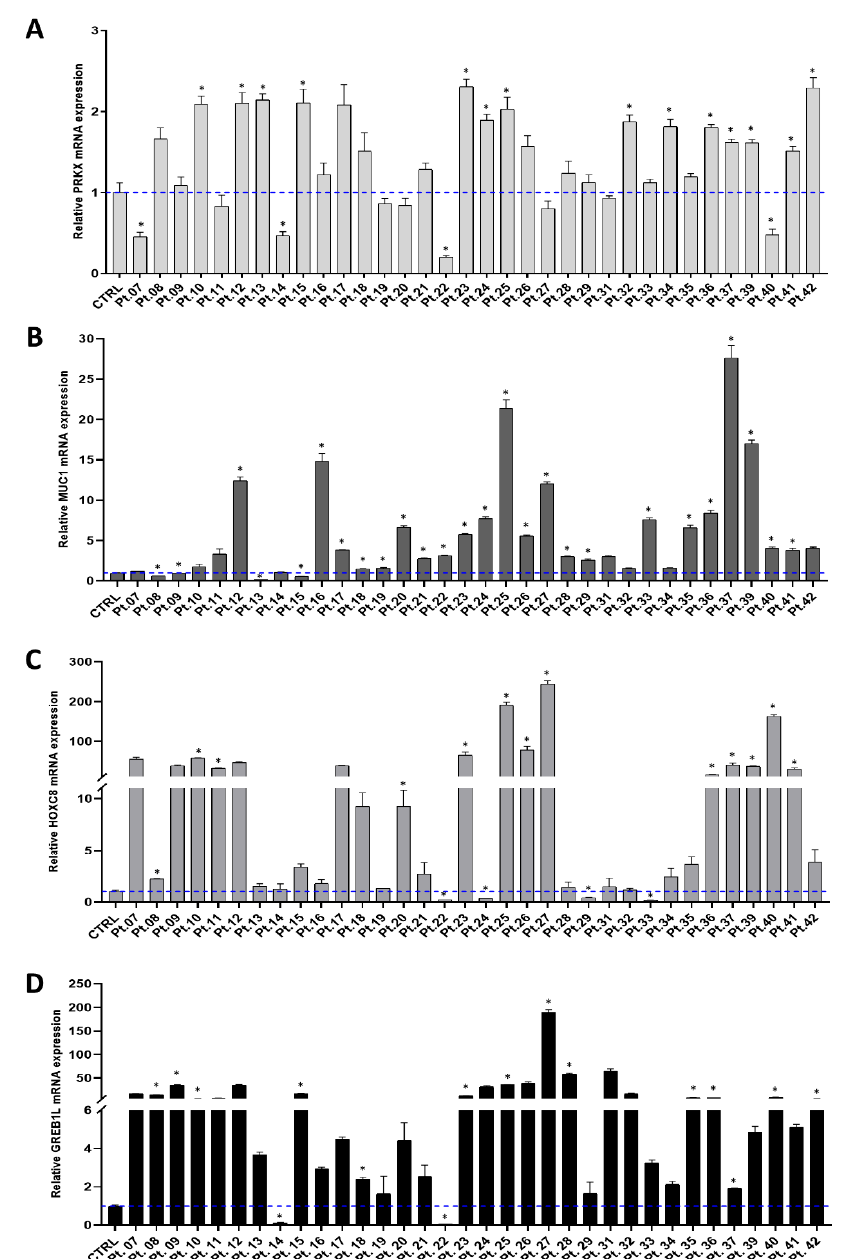
Figure 1. Candidate gene expressions in the cohort of MRKH patients. RT-qPCR analysis performed on RNA extracted from primary vaginal keratinocytes showing PRKX ( A ), MUC1 ( B ), HOXC8 ( C ) and GREB1L ( D ) relative mRNA levels with respect to a pool of 4 healthy control women, indicated with a blue dashed line (mean ± SD; n = 3; * p < 0.05; Student’s t -test).